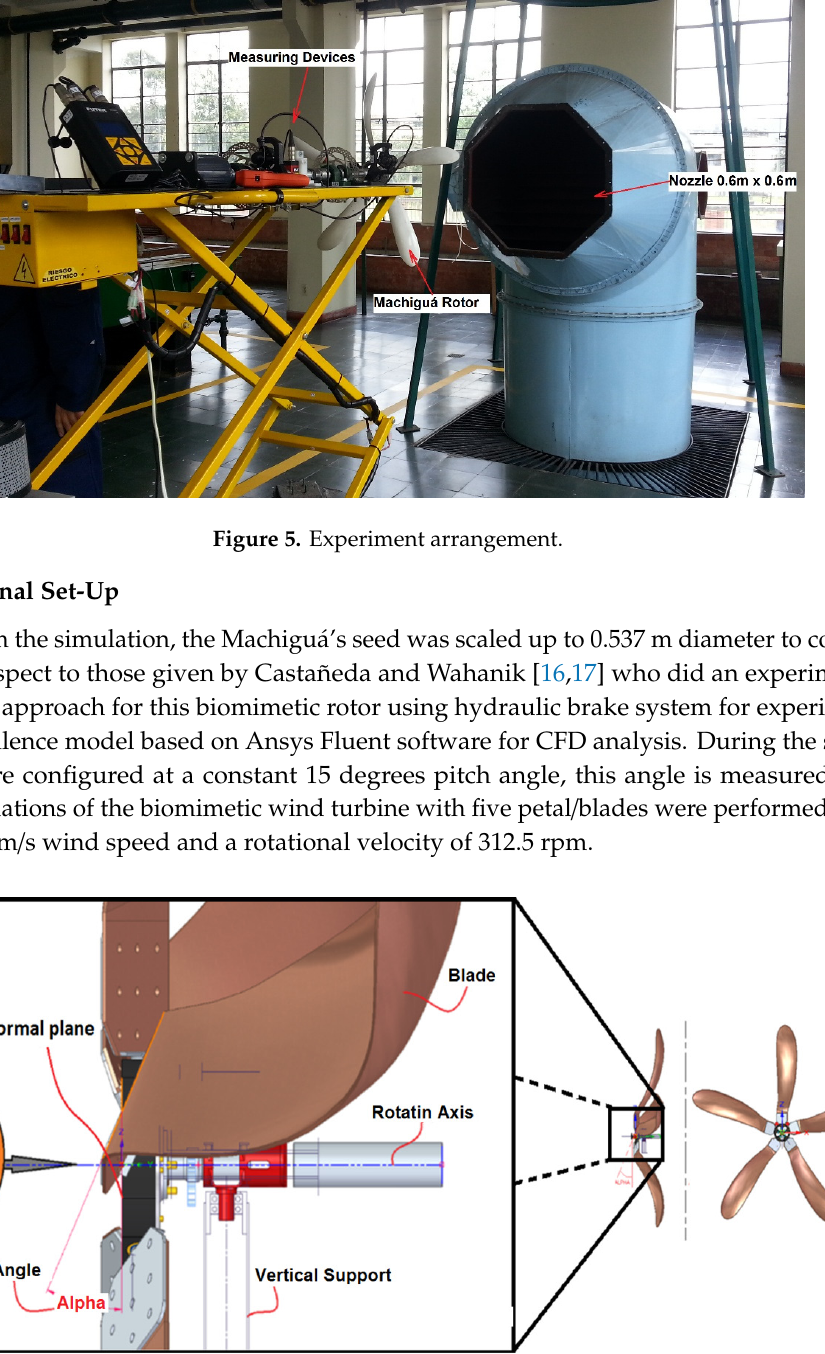
Figure 4. Wind rotor Test bench. ( a ): Main parts. ( b ): Isometric view.